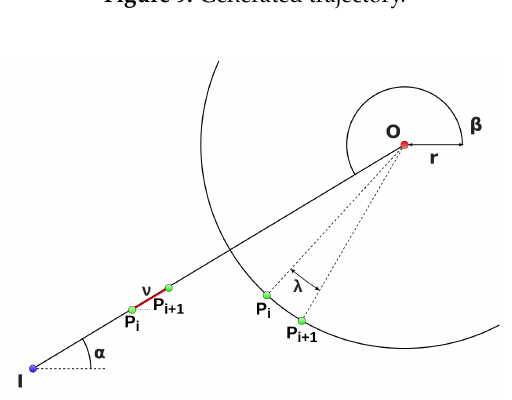
Figure 10. Generated